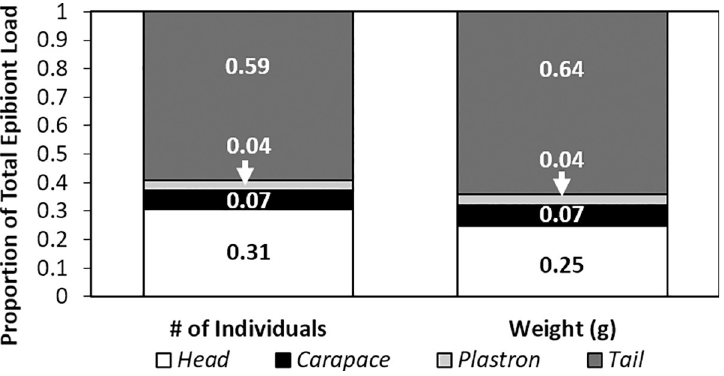
Fig 2. Proportion of the total epibiont load found on the four body regions (head, carapace, plastron, and tail) of olive ridley sea turtles. The left graph represents % abundance and the right graph represents % total biomass.